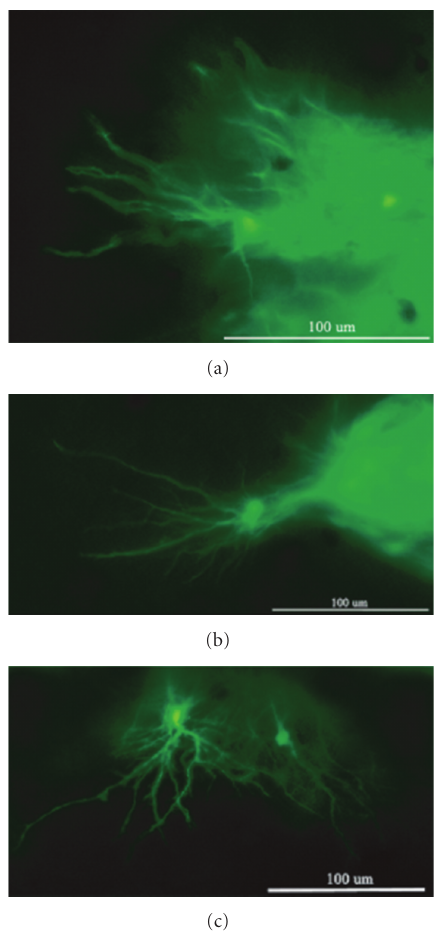
Figure 3: Arborization of grafted cells in dystrophic recipient retina. Recipient was 9 weeks of age at time of transplantation and experiment terminated 9 weeks later. Photomicrograph of a retinal wholemount viewed en face using fluorescence microscopy. Image reveals GFP+ profiles within the retina of rhodopsin Pro347Leu recipient. Inspection of regions near the edge of the graft allows visualization of individual donor-derived cells and reveals extension of elaborate processes in the plane of focus.